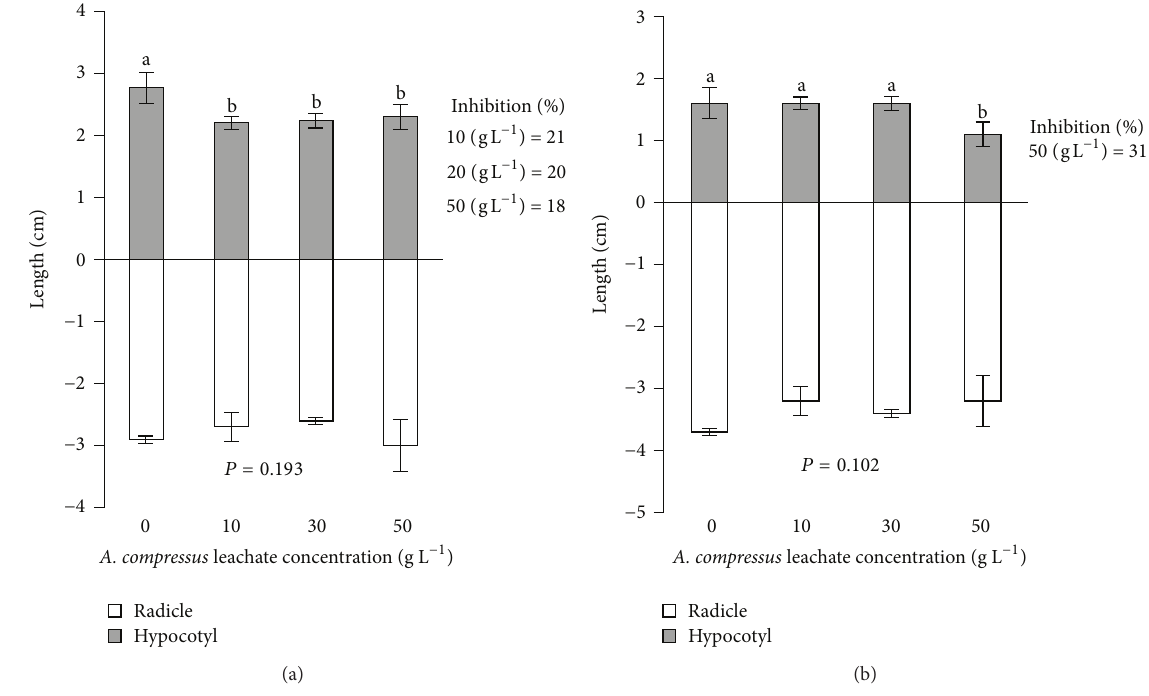
Figure 3: Effect of A. compressus litter leachates on seedling growth of A. gangetica (a) and P. polystachion (b). The error bars are standard deviations (SD) of four replicates. The vertical bars (mean ± SD), denoted with same letters, indicate a nonsignificant difference at 𝑃 = 0.05 according to Tukey’s test.